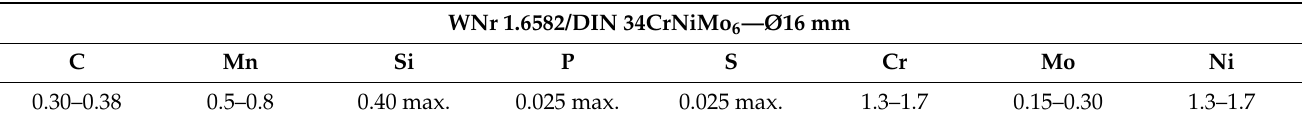
Table 1. Chemical composition (wt.%) of the welding tool material.